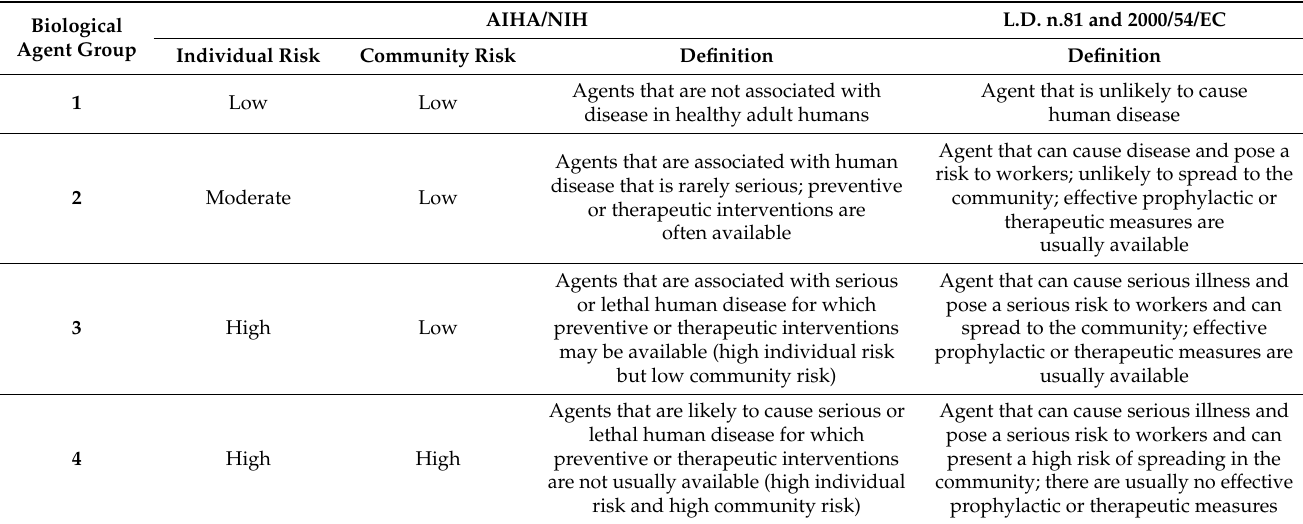
Table 1. Biological agent classification according to the American Industrial Hygiene Association (AIHA) and the National Institutes of Health (NIH) and to L.D. n.81-2000/54/EC. Biological Agent